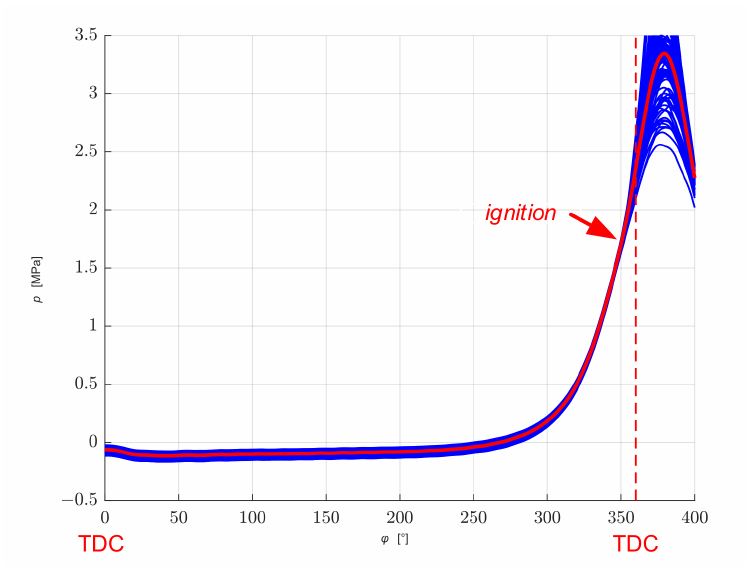
Figure 1. Example waveforms of 100 consecutive engine work cycles and an average waveform for constant operating